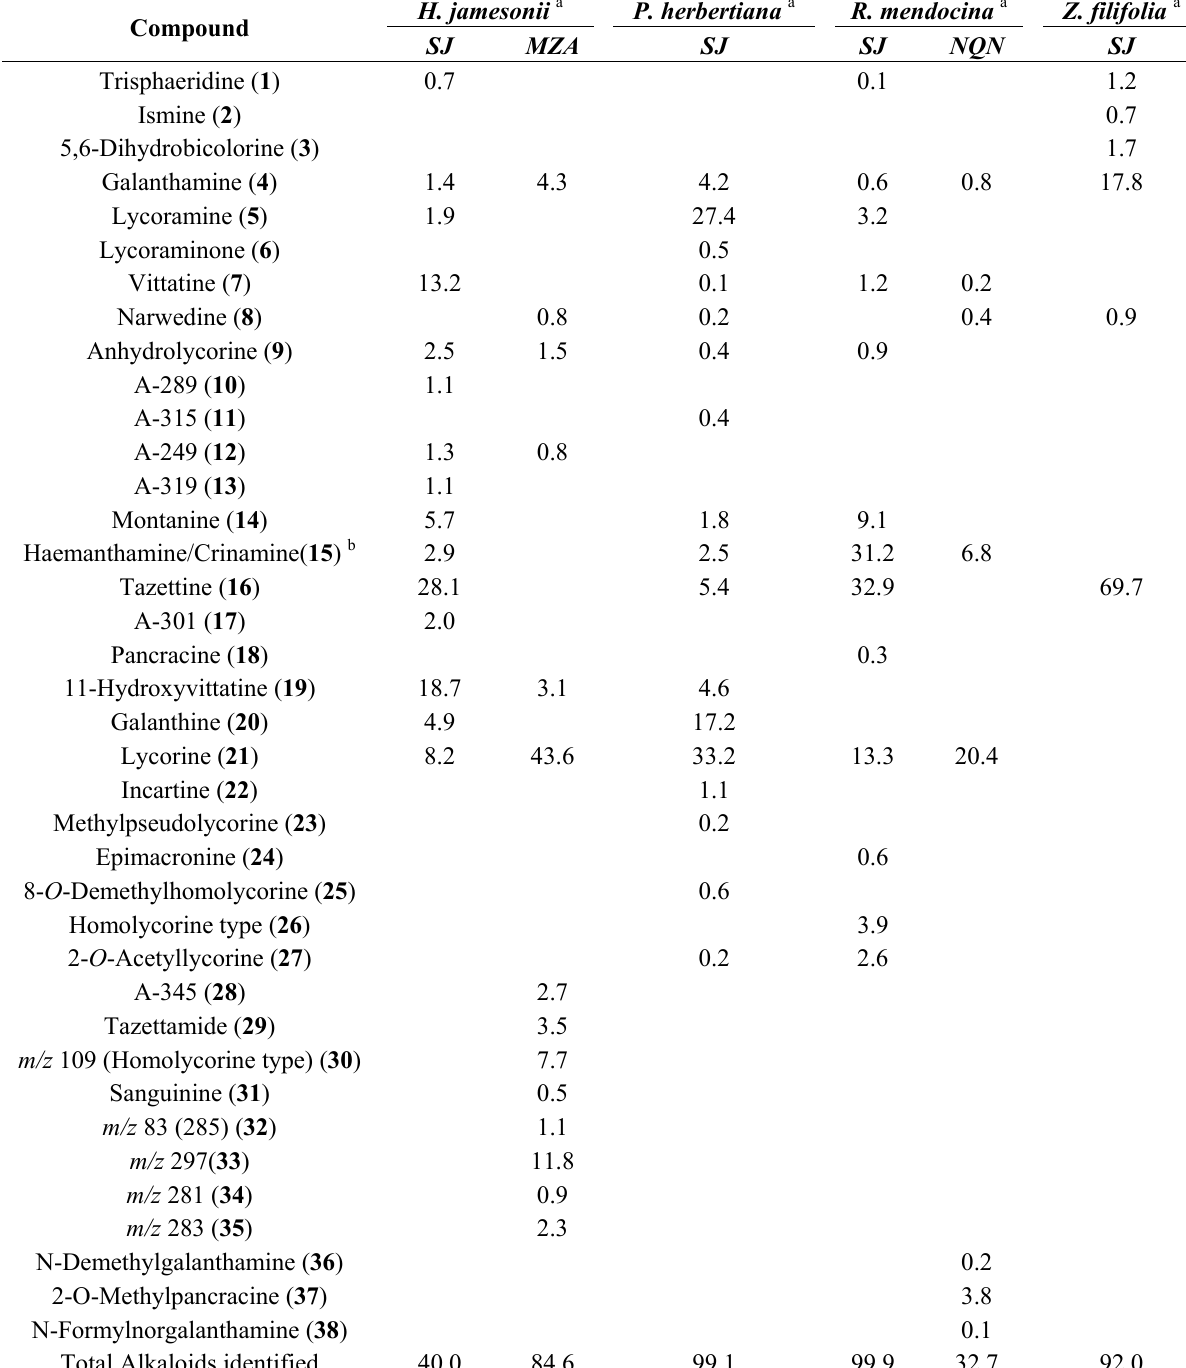
Table 2. Alkaloid composition of four Amaryllidaceae